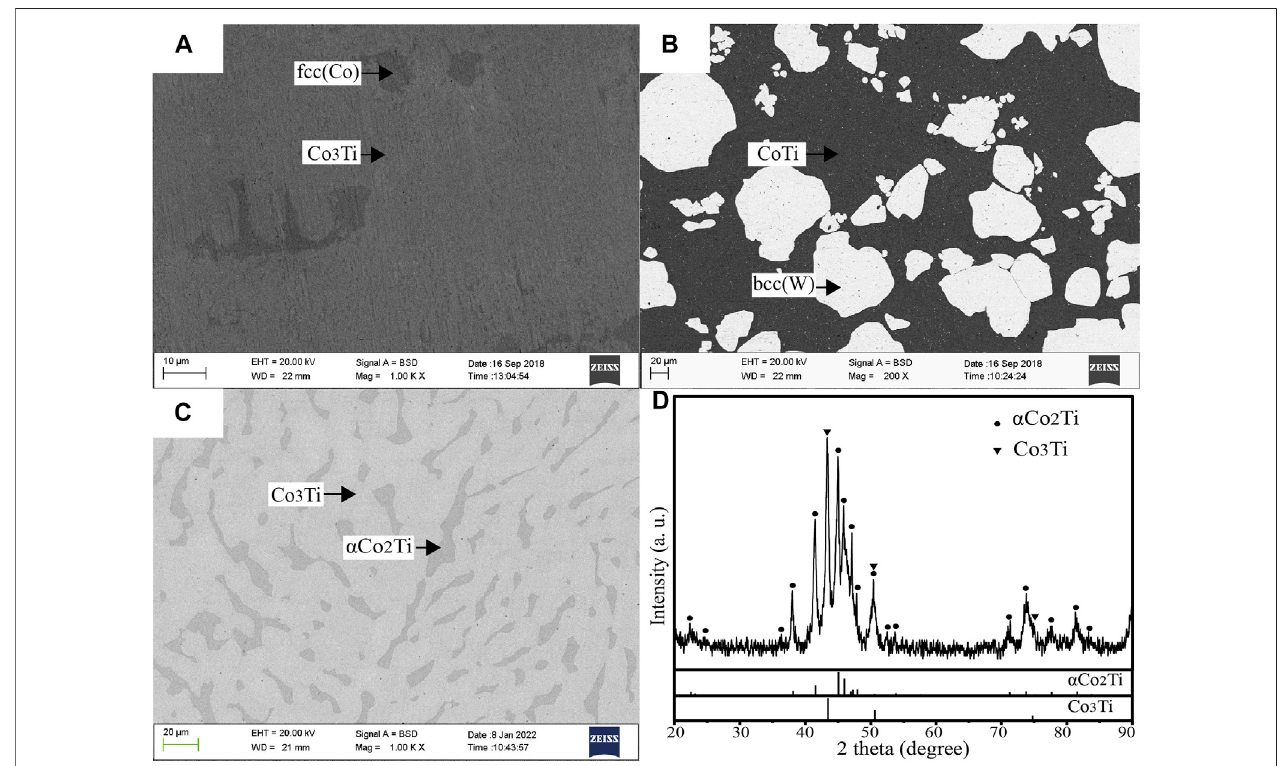
FIGURE 6 | BSE micrographs and XRD pattern of alloys (A) for a13 (B) for a14 (C) and (D) for a15.